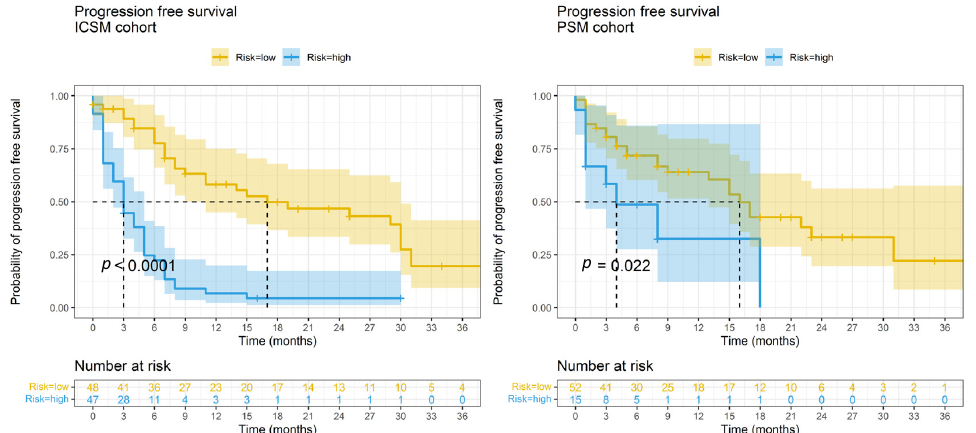
Figure 2. Kaplan–Meier curves of high and low risk of progression patients based on PFS nomograms predictions. Survival profiles of patients at high risk of progression (characterized by total points from the PFS nomogram ≥ 104) and low risk of progression (characterized by total points from the PFS nomogram < 104) in the ICSM and OSM datasets, respectively. p = p -value from the log-rank test. Graphical representation was truncated at 36 months.